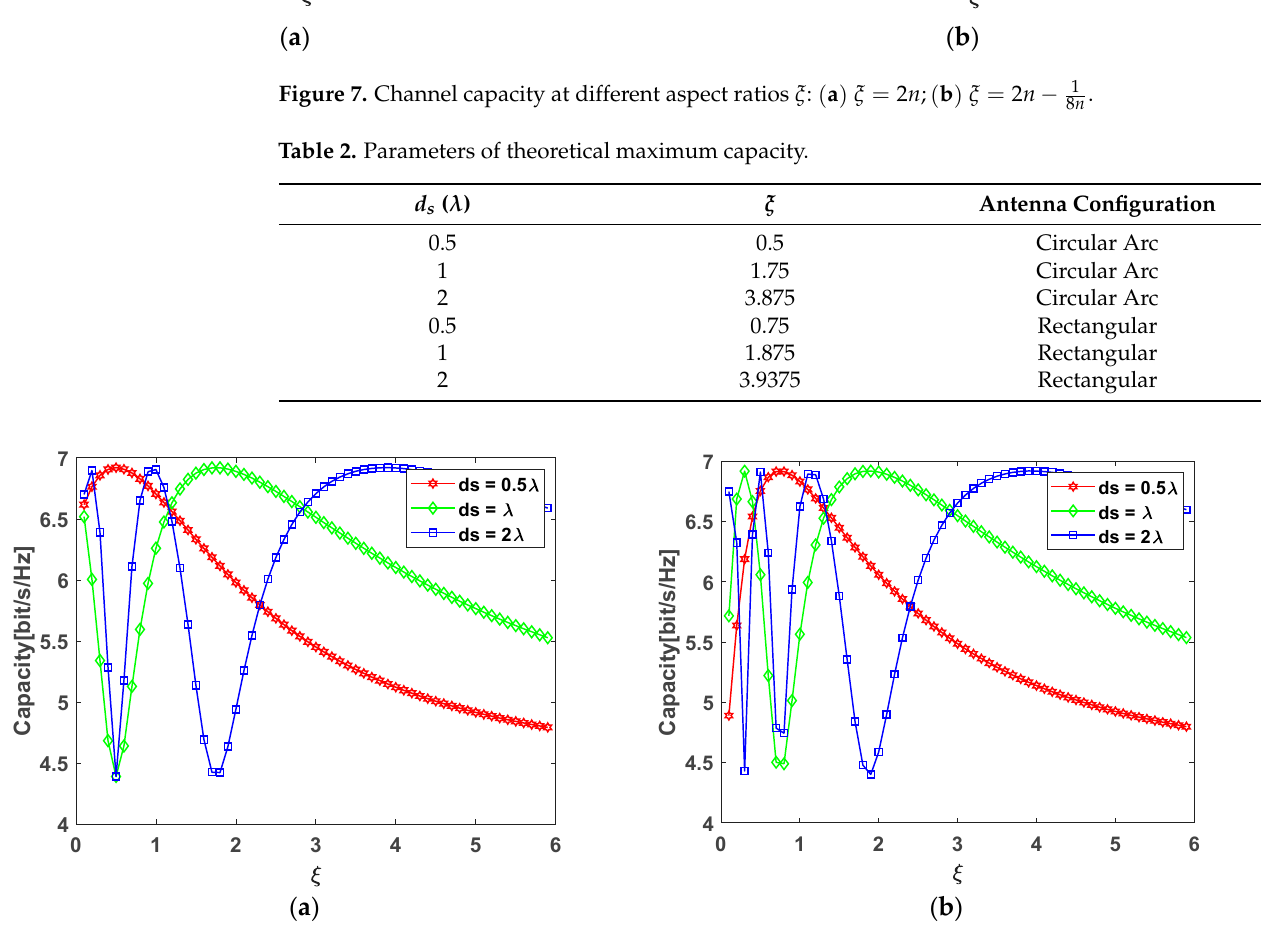
( b ) Figure 9. Channel capacity under two different 3 × 3 antenna configurations: ( a ) circular arc antenna array; ( b ) rectangular antenna array.